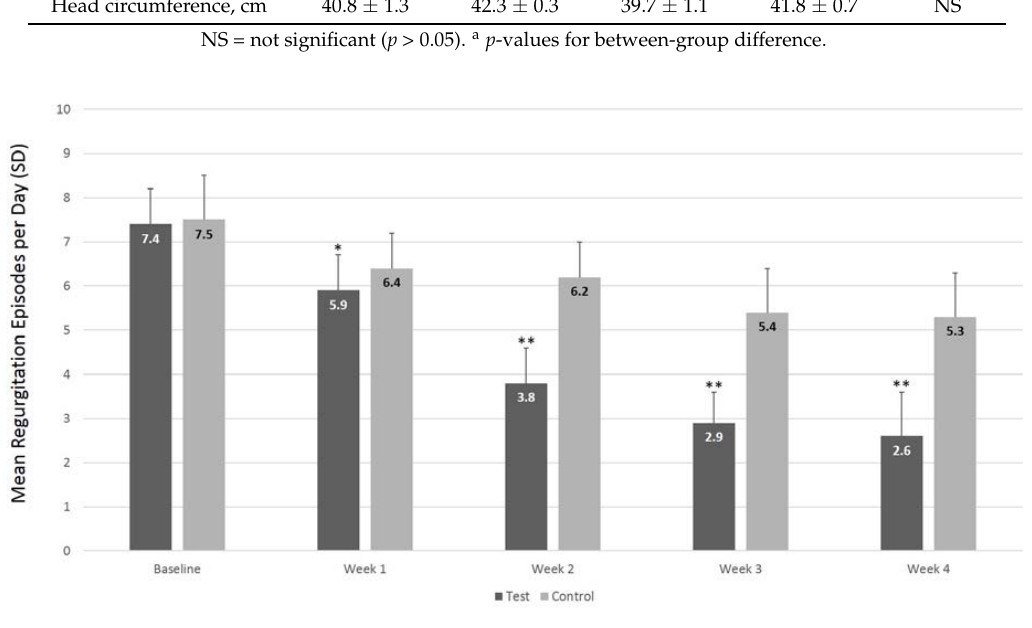
Figure 2. Mean number of daily regurgitation episodes by week in the test and control groups. Repeated measures ANOVA showed a significant difference between groups ( p < 0.0001) over the entire study period. Means at each time point were compared using Student t -test for unpaired samples. * p = 0.0094; ** p < 0.0001.